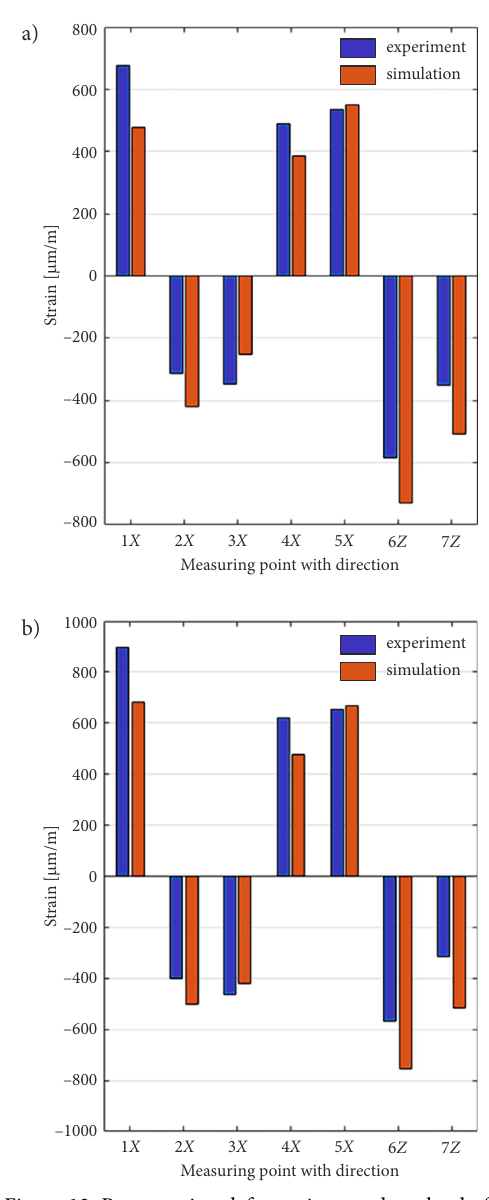
Figure 12. Pump casing deformations under a load